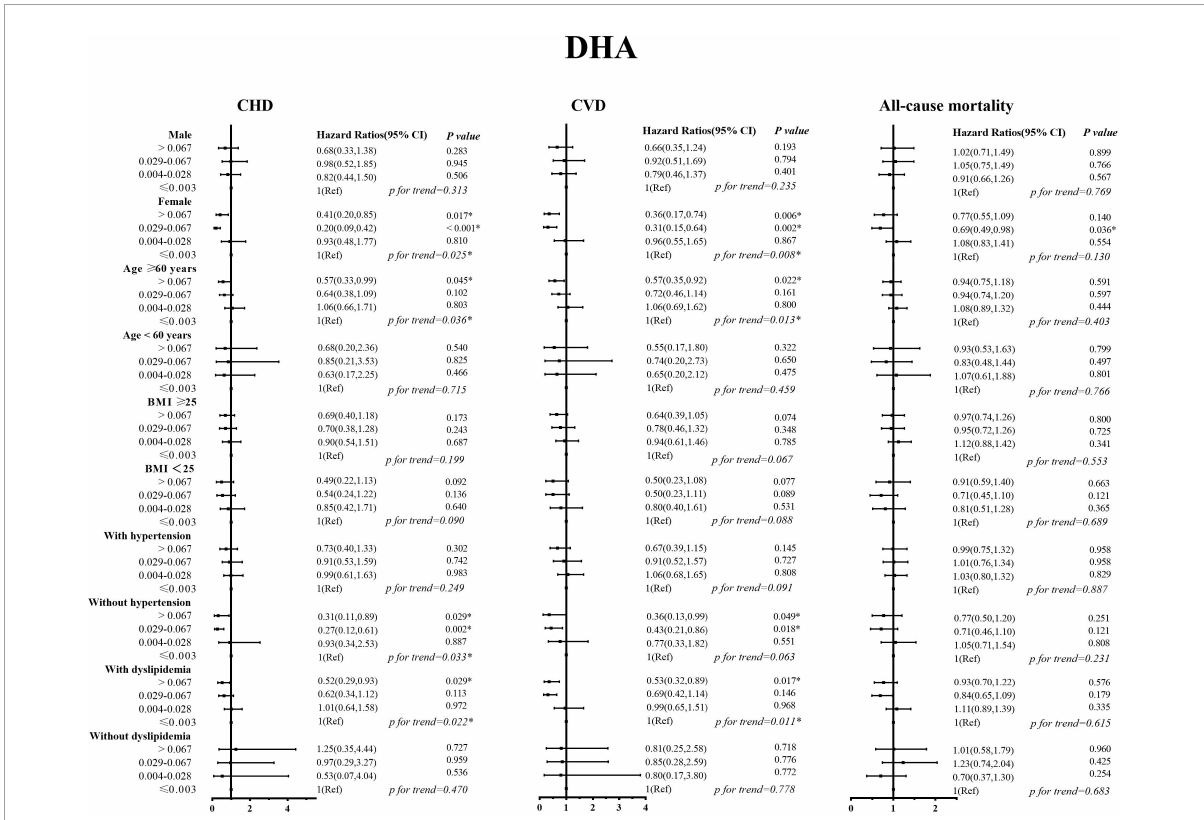
FIGURE3 Stratified analyses by sex, age, body mass index, history of hypertension, and history of dyslipidemia for the associations between DHA and the mortality from cardiovascular disease, coronary heart disease, and